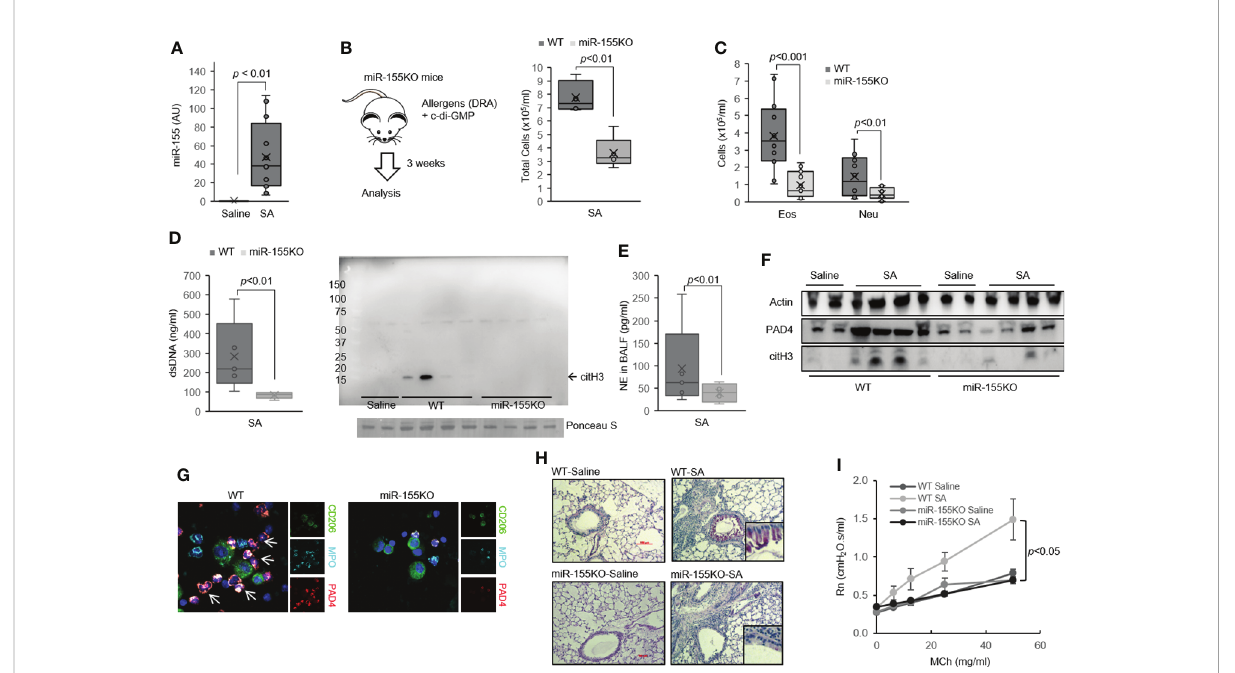
FIGURE 3 MiR-155 is involved in ET formation in severe asthma (SA). (A) Expression of miR-155 in lung from SA mice (N = 3 – 5). (B) Total cells and (C) leukocyte differentials were counted in the BALF of the mouse model of SA used in the study (N = 6-8). (D) PicoGreen assay and Western immunoblot for citH3 showing ET-associated DNA present in BALF. (E) NE in the BALF from WT and miR-155KO mice (N = 5). (F) PAD4 and citH3 proteins as determined by Western immunoblotting from SA mouse lung. (G) Representative confocal microscopy images of BAL cells from SA mice producing MPO with co-expression of PAD4 (arrow). Blue, staining for DNA; cyan, MPO; green, macrophages; red, PAD4. (H) PAS-stained sections from WT (top) and miR-155KO (bottom) mouse lungs subjected to the SA model. Boxed regions are shown enlarged at right. (I) Airway hyperresponsiveness (AHR) in WT and miR-155KO mice subjected to the SA model. Graphs were plotted as mean ± SE. p-Values were obtained using a two-tailed Student ’ s t-test. ET, extracellular trap; BALF, bronchoalveolar lavage fl uid; NE, neutrophil elastase; MPO, myeloperoxidase; PAS, periodic acid-Schiff; WT, wild